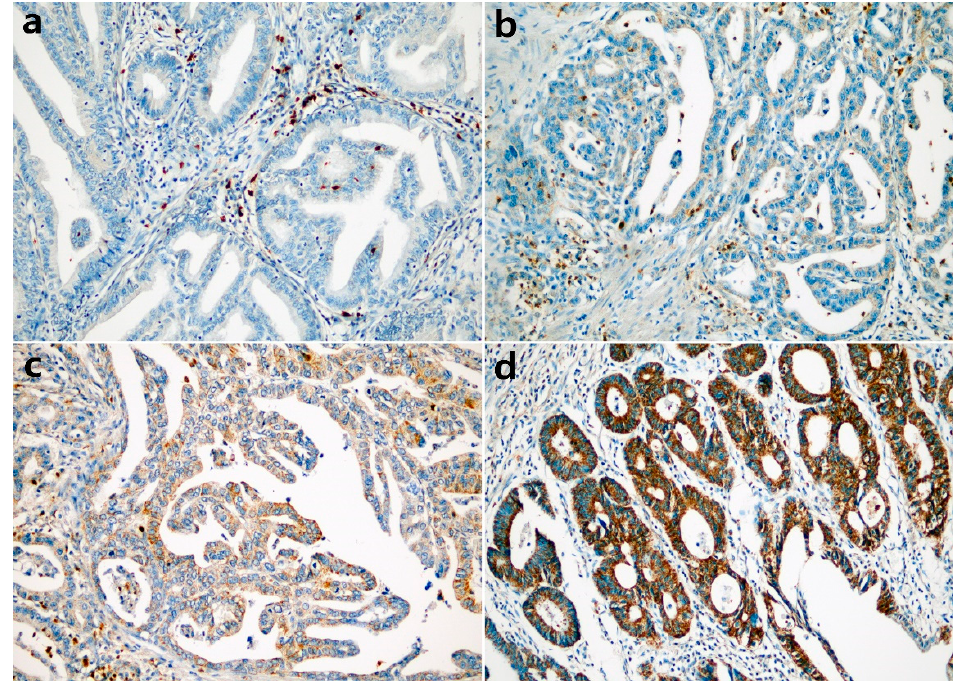
Figure 1. Representative photomicrographs of immunohistochemical staining with CADM4 in gastric adenocarcinoma (( a ): negative, ( b ): weak, ( c ): moderate, ( d ): strong, ×200). Table 2. Correlations between CADM4 expression and clinicopathological characteristics in pa- tients with gastric adenocarcinoma ( n = 534).